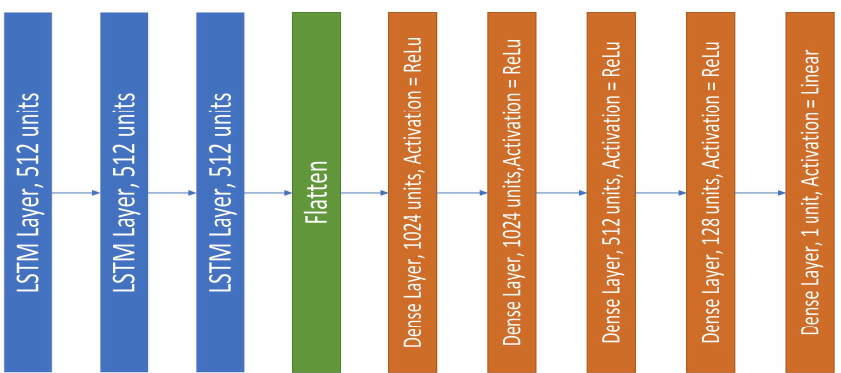
Figure 5. Architecture of the LSTM model.